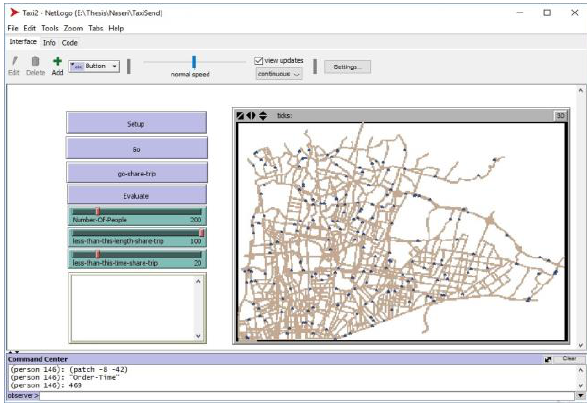
Figure 4. The NetLogo software and the customized model